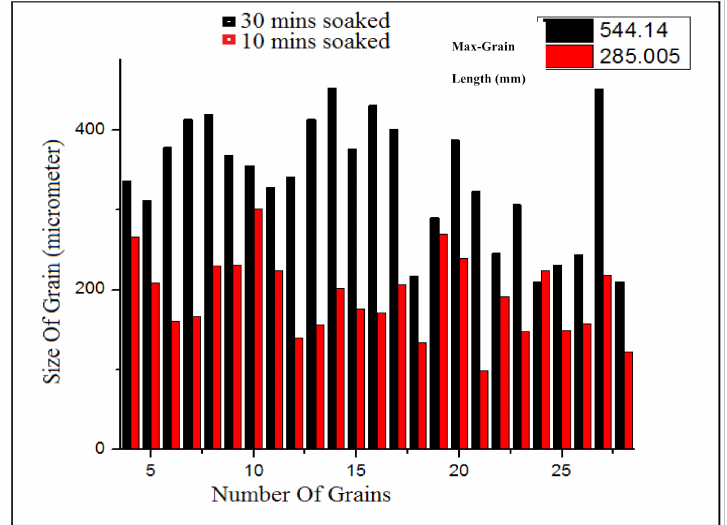
Figure 5. Bar graph showing the difference of grain growth with variation in the soaking